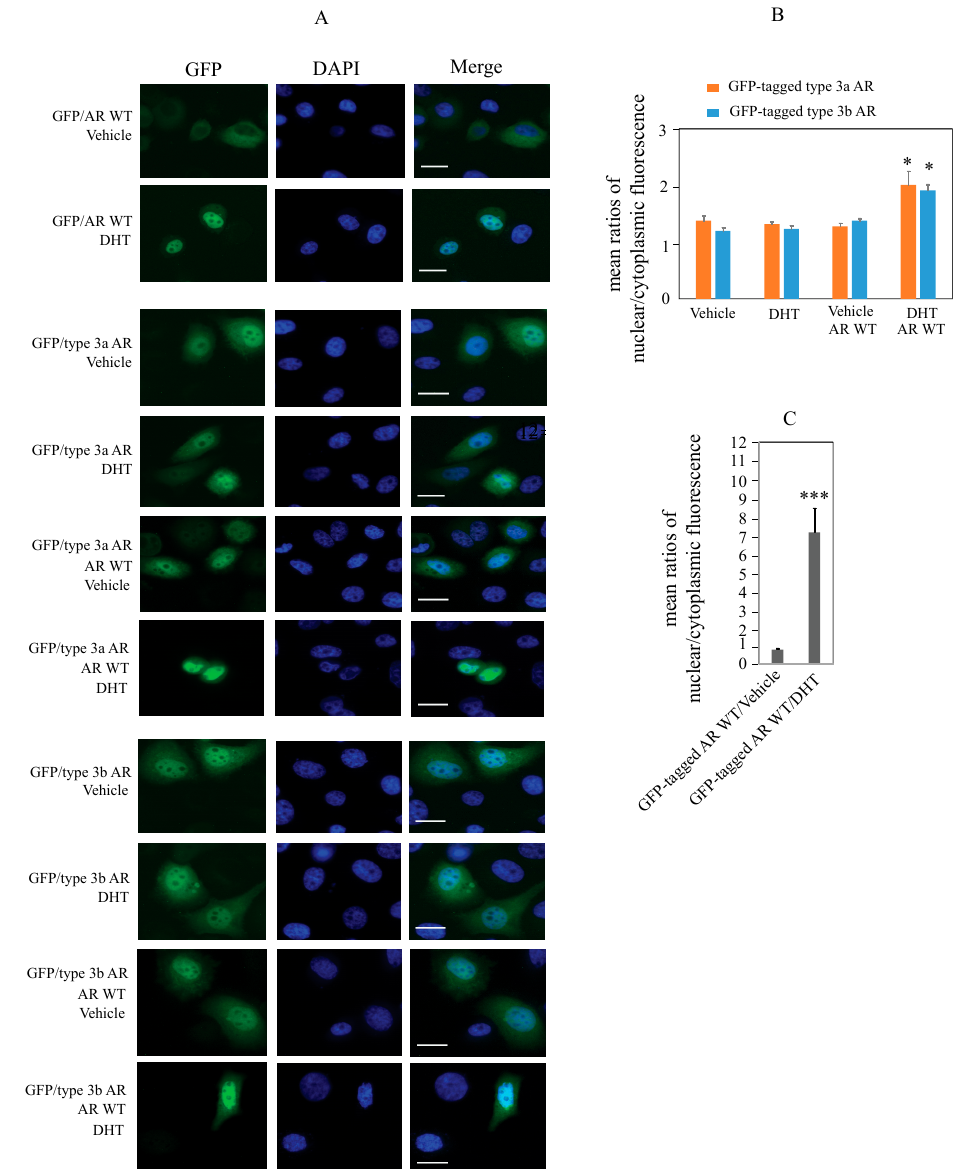
Figure 5. GFP-tagged type 3 AR proteins localize to both the cytoplasm and nuclei of AR-negative prostate cancer PC3 cells under androgen-depleted conditions; co-expression with wild-type AR enhances the nuclear localization of type 3 AR in the presence of DHT. ( A ) Fluorescence images of PC3 cells transfected with GFP-tagged wild-type AR (GFP/AR WT), GFP/type 3a AR, GFP/type 3b AR, or co-transfection of untagged AR WT with GFP-tagged type 3a or 3b AR (green) and DAPI (blue) after 4 h treatment with vehicle or 10 nM DHT. Scale bars represent 20 µm; ( B ) Average mean fluorescence ratio of nuclear:cytoplasmic GFP/type 3a AR or GFP/type 3b AR in vehicle- or DHT-treated PC3 cells; ( C ) Average mean fluorescence ratio of nuclear:cytoplasmic GFP/AR WT in vehicle- or DHT-treated PC3 cells. Fluorescence from a total number of 20–35 cells per condition was quantified as described under Methods. Error bars represent SEM. Statistical analysis was carried out by GraphPad Prism 6 (GraphPad Software, La Jolla, CA, USA) using two-way ANOVA ( B ) or independent t -test ( C ). p < 0.05 (*), p < 0.001 (***).